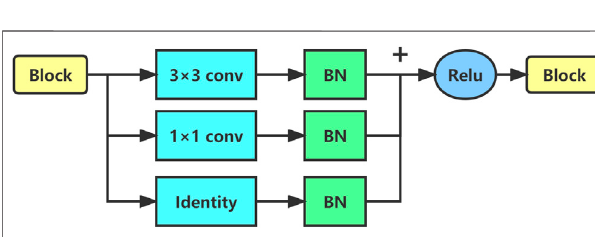
FIGURE 3 | Sketch of RepVGGBlock